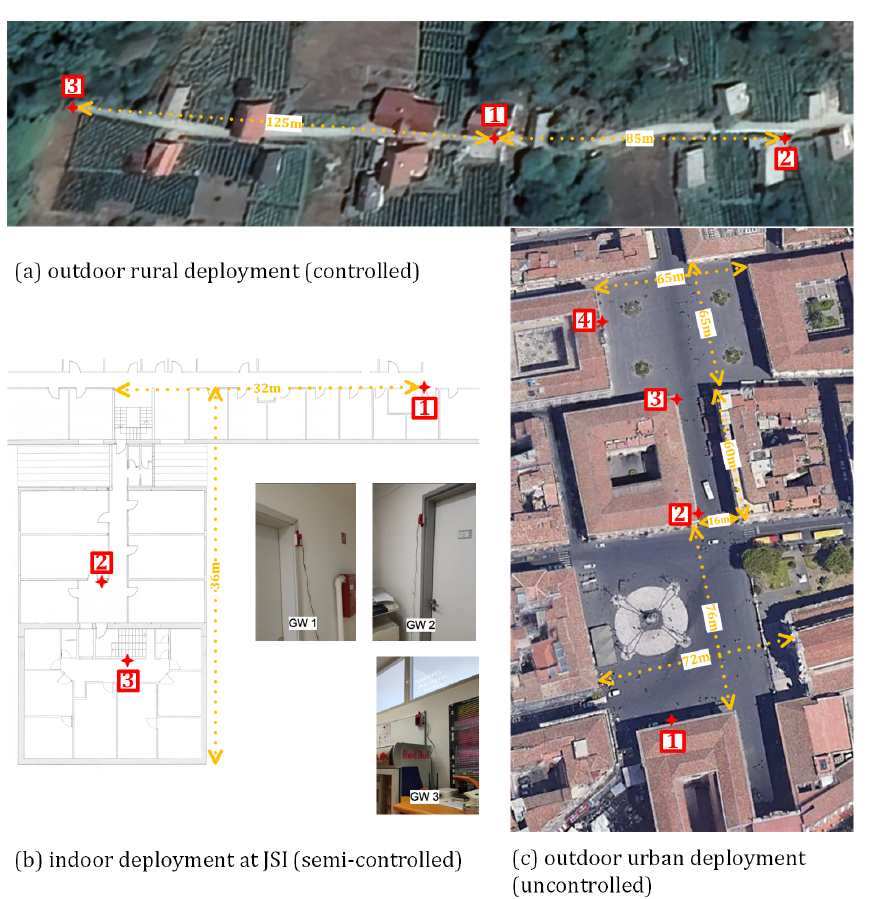
Figure 6. Locations of probe requests